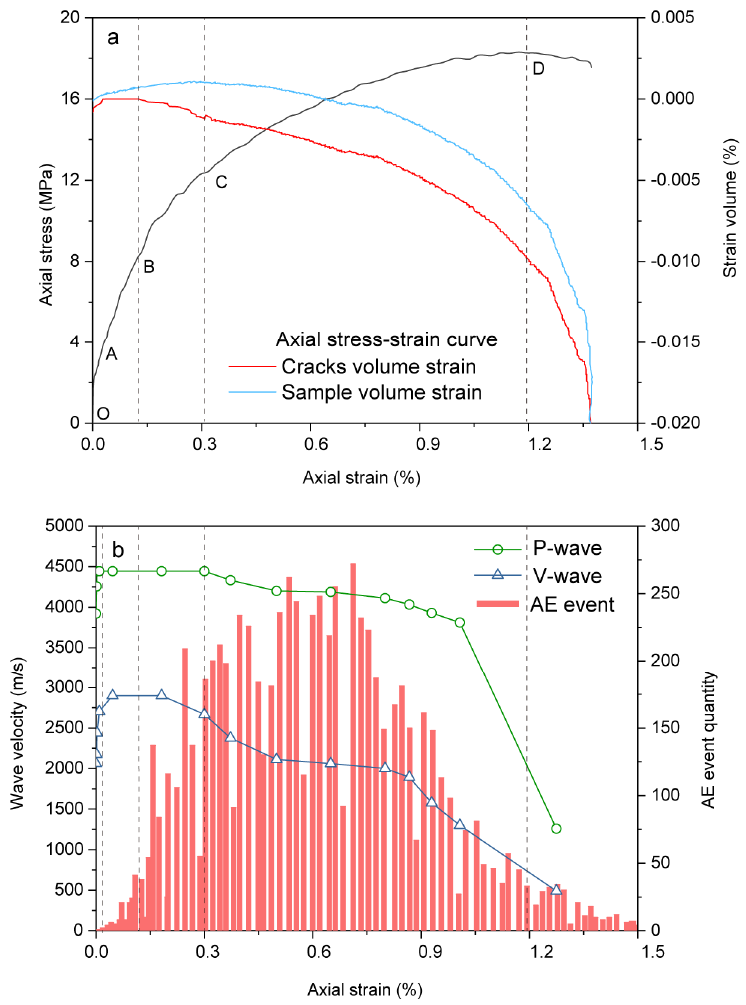
Figure 4. ( a ) Axial stress–strain relationship for sample SA-2 under uniaxial compression; ( b ) the relationship between ultrasonic velocity and AE activity for sample SA-2 under uniaxial compression.